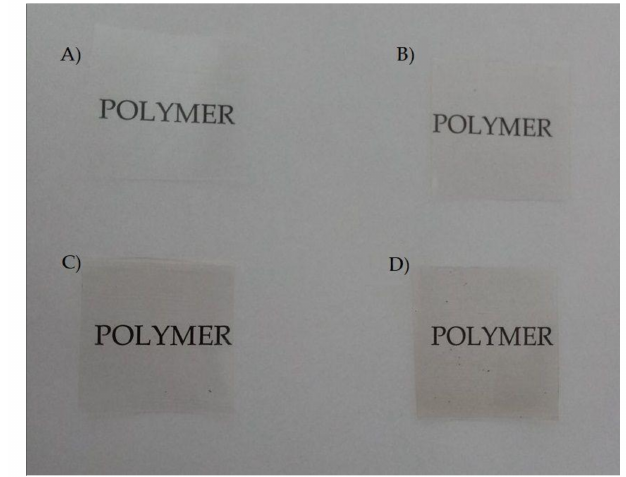
Figure 5. The visual appearance of the films: ( A ) pure PLA film ( B ) 0.025% PLA/melanin film ( C ) 0.05% PLA/melanin film ( D ) 0.2% PLA/melanin film.